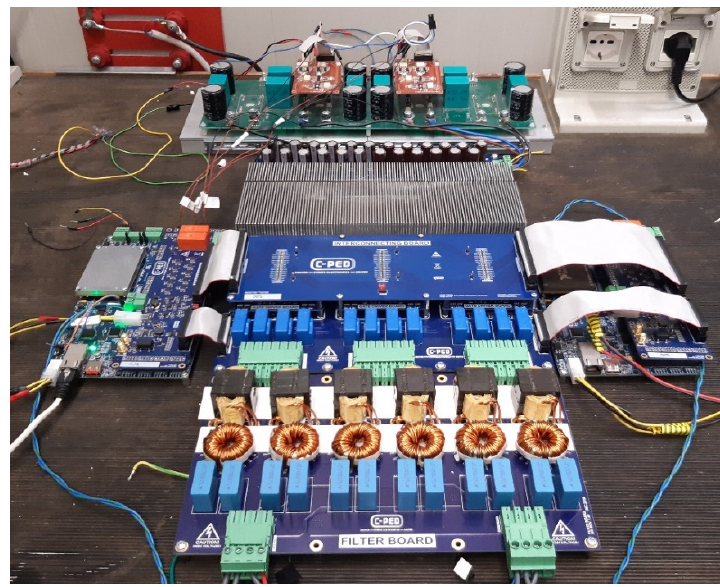
Figure 17. Experimental setup of the 3 Φ 5L E-Type MMR and MMI.